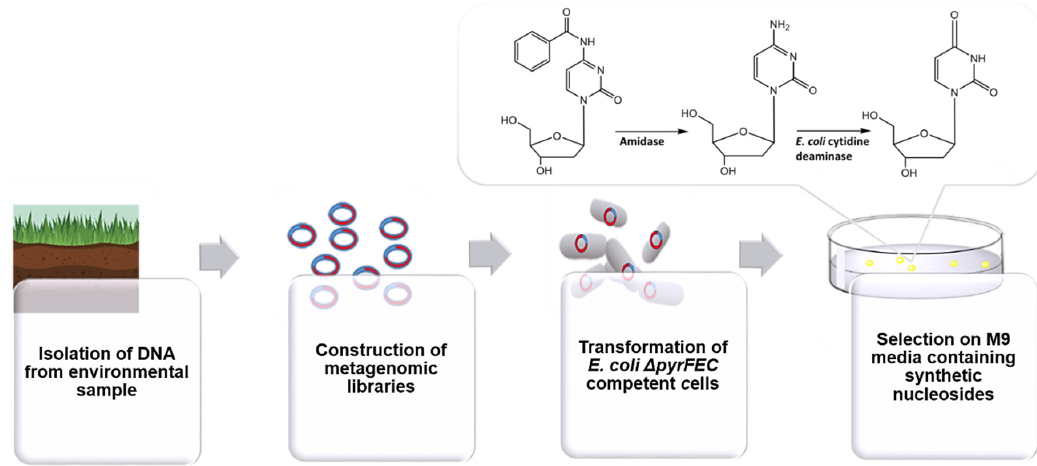
Figure 1. The principle of amidohydrolase selection. Metagenomic DNA isolated from the